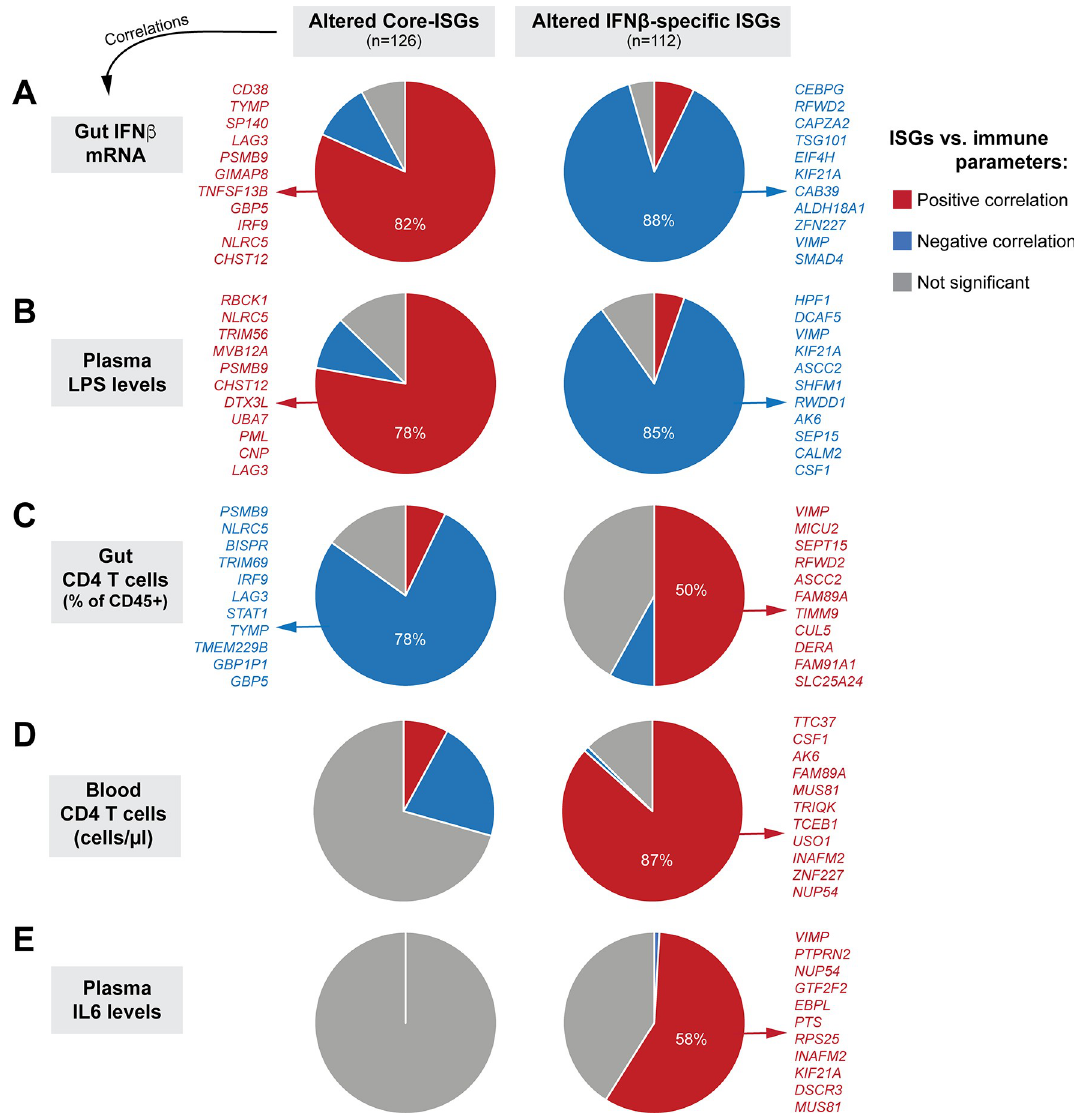
Fig 8. Percentages of Altered Core and IFN β -specific ISGs that correlated with clinically relevant parameters during chronic mucosal HIV-1 infection. Correlations between the expression of individual core-ISGs (Fig 6A) and IFN β -specific ISGs (Fig 7A) in gut biopsies from the clinical cohort were determined against (A) gut IFN β transcripts, (B) plasma LPS levels, (C) gut CD4+ T cell percentages, (D) Blood CD4 T cell counts and (E) Plasma IL6 levels using linear regression models, controlling for age and gender. The clinical cohort included PWH (n = 19) and matched HIV uninfected controls (n = 13). Correlations with FDR � 5% were considered significant; the proportion of those core and beta ISGs are plotted as pie charts, with red, blue and gray depicting positive, negative and no significant correlations, respectively. The top genes in the relevant categories with � 50% representation are highlighted; a full list is available in S12 Table.